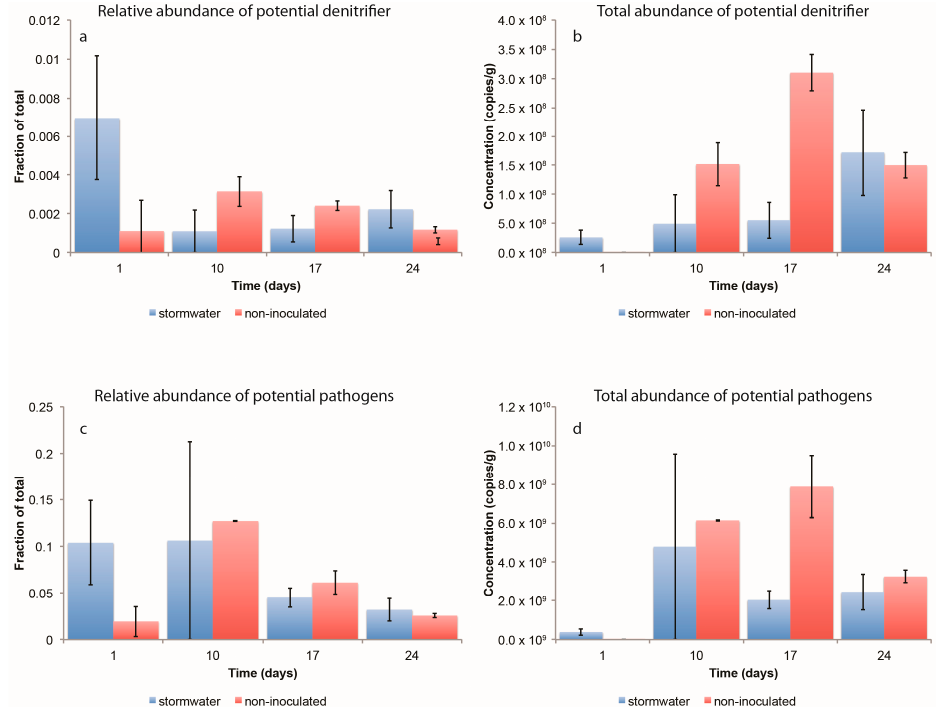
Figure 6. Relative ( a , c ) and total ( b , d ) abundance of potential denitrifying ( a , b ) and pathogenic ( c , d ) microbial taxa over time within non-inoculated, (red) and stormwater inoculated (blue) columns. ( a ) The relative abundance of potential denitrifying taxa within the community over time. ( b ) The abundance of denitrifying taxa within the sand columns over time. The total number of 16S rRNA gene copies per gram was multiplied by the fraction of the total community to provide a quantitative measure of changes of potential through time. ( c ) The relative abundance of potentially pathogenic taxa within the community over time. ( d ) The abundance of potentially pathogenic taxa within the sand columns over time. The total number of 16S rRNA gene copies per gram was multiplied by the fraction of the total community to provide a quantitative measure of changes of potential through